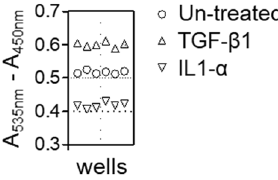
Figure 3. Detection of cytokine-mediated activity. Proteoglycan production in primary chondrocytes treated with TGF-β1 (10 ng/mL) or IL1-α (10 ng/mL) for 3 days was evaluated by the miniaturized DMMB assay. Readouts were recorded as the average of six reactions (wells) from three independent